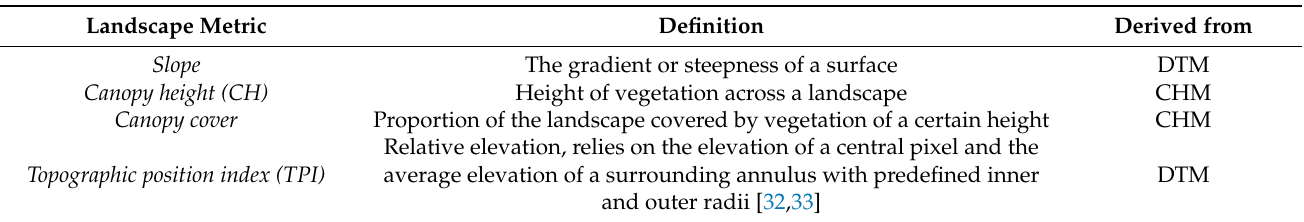
Table 2. Summary of landscape